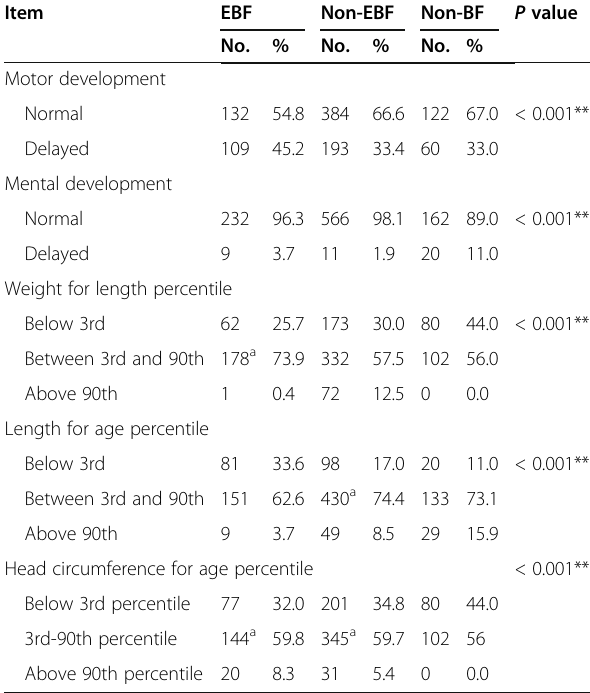
Table 3 The effect of feeding patterns on infant growth and development